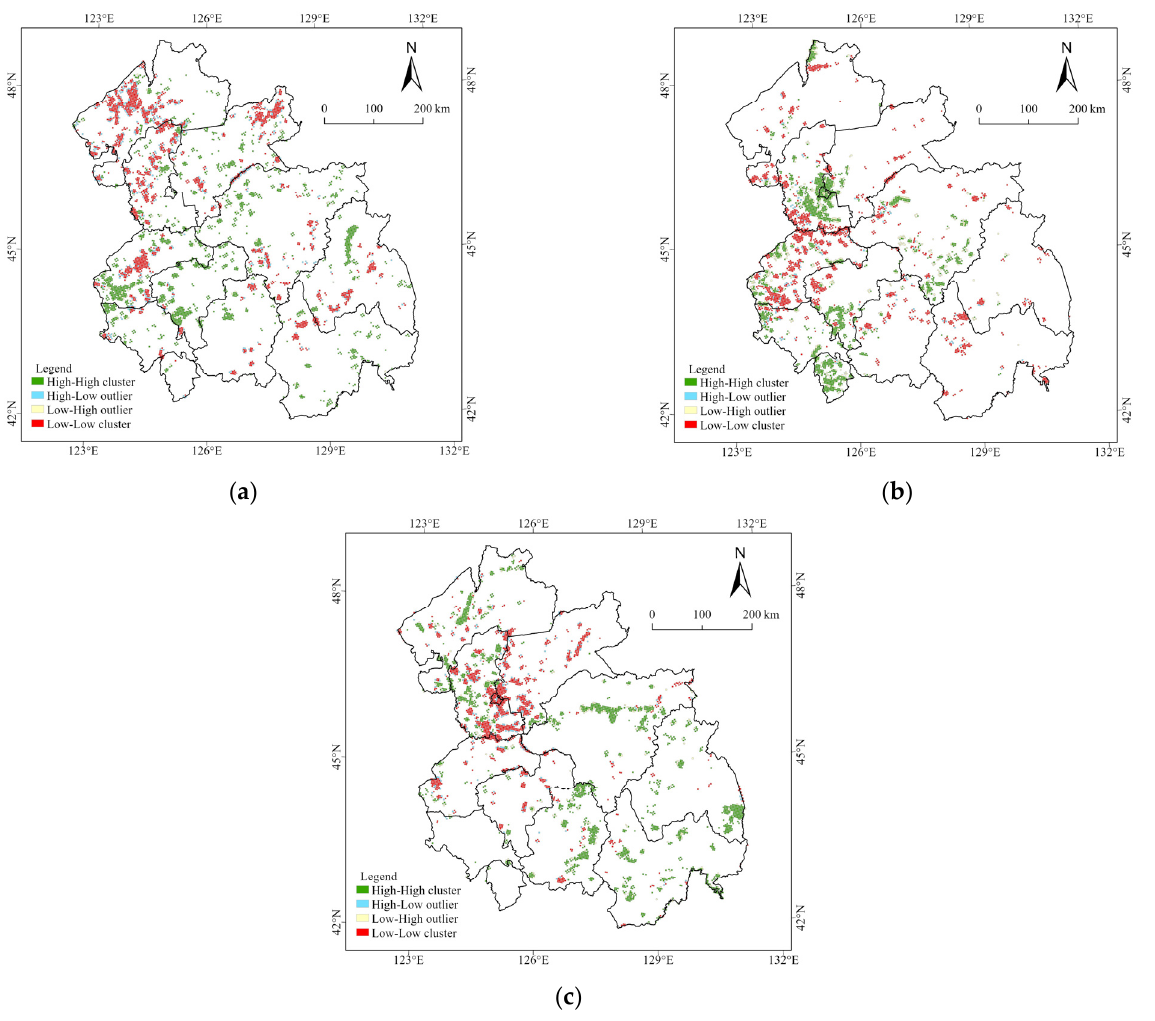
Figure 8. Hotspots of ecological land change: ( a ) 1990 to 2000; ( b ) 2000 to 2010; ( c ) 2010 to 2020.